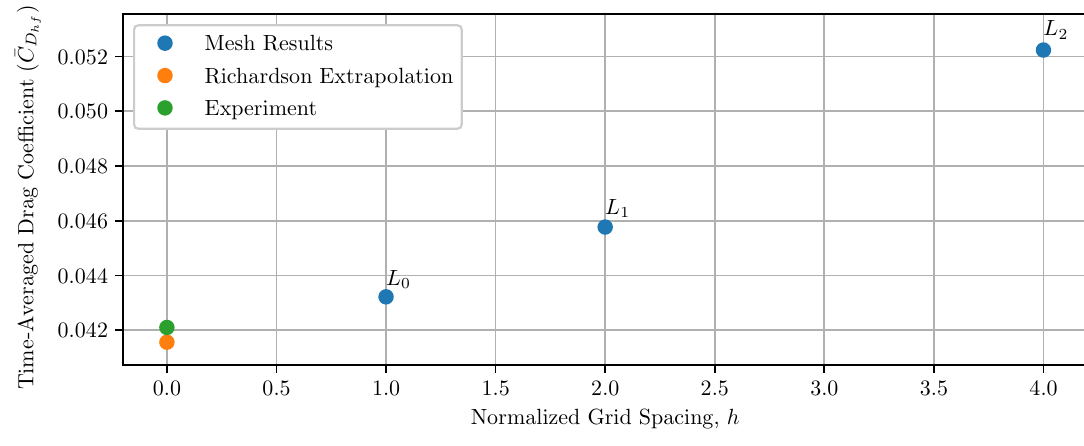
Figure 9. Grid convergence study via Richardson